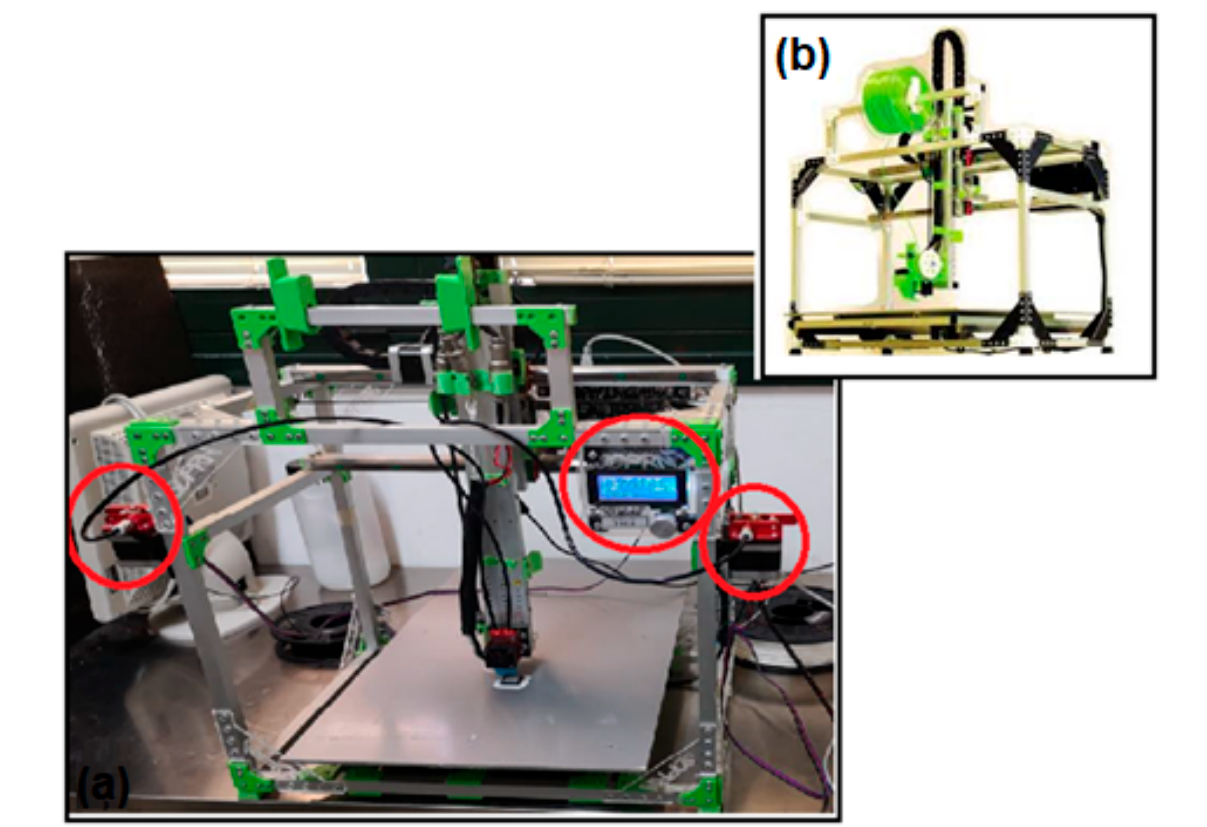
Figure 1. ( a ) 3DPRN LAB printed after modification of hardware and software components; ( b ) 3DPRN LAB commercial printed. The red circles are the modified parts of the 3D printer.